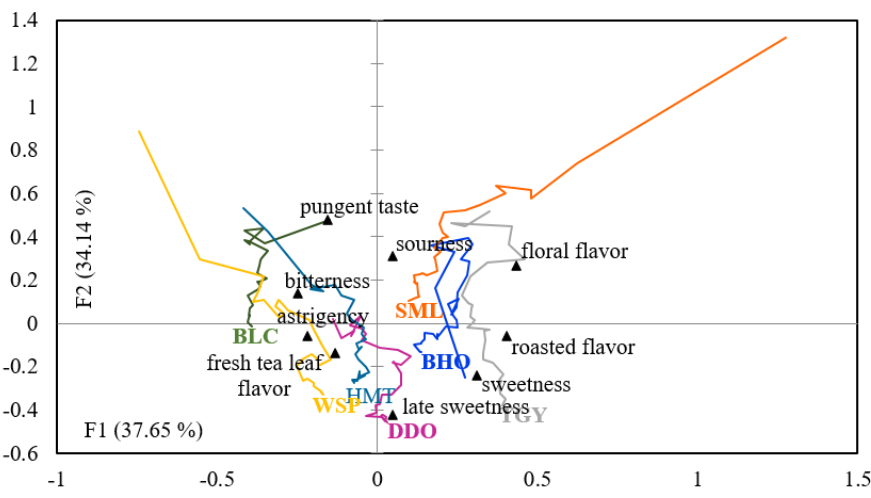
Figure 6. Trajectory CA graphical representations for Taiwanese tea beverages brewing with cold water on nine sensory attributes using temporal check-all-that-apply.